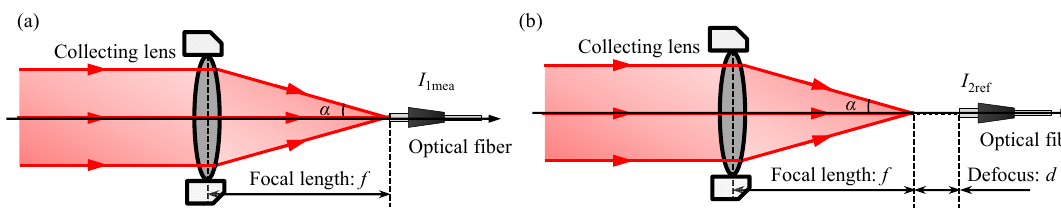
Figure 1. Schematics of the relative position between the fiber core and the collecting lens in measurement and reference detectors in the femtosecond confocal probe. ( a ) A setup for the measurement detector. ( b ) A setup for the reference detector with a defocus d.